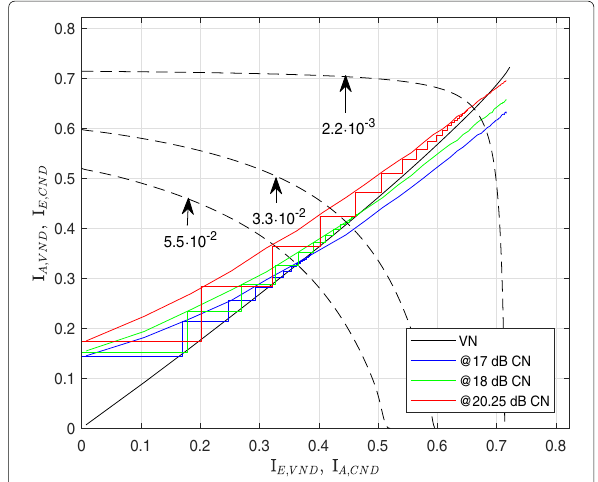
Fig. 4 EXIT chart, BER contour lines, and mutual information trajectory for a pure RCM code of ρ = 7.4 when transmitting a non-uniform source with entropy H ( p 0 ) = 0.72 over an AWGN channel